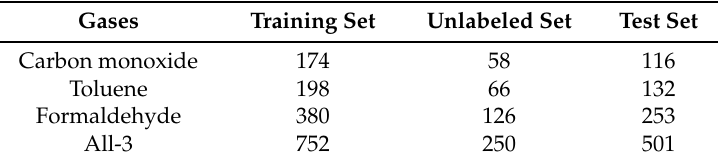
Table 4. Amount of samples in a data set with 25% unlabeled rate.